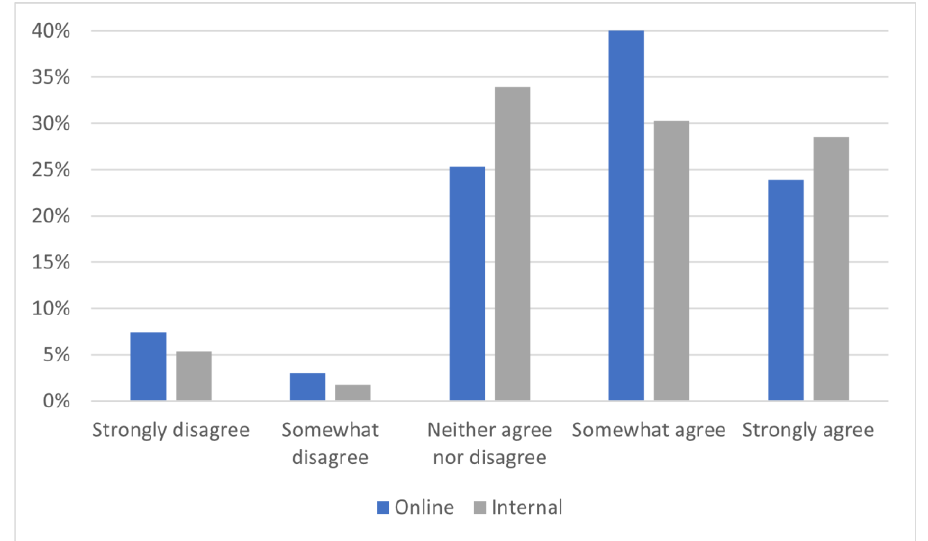
Perceptions that online study skills had